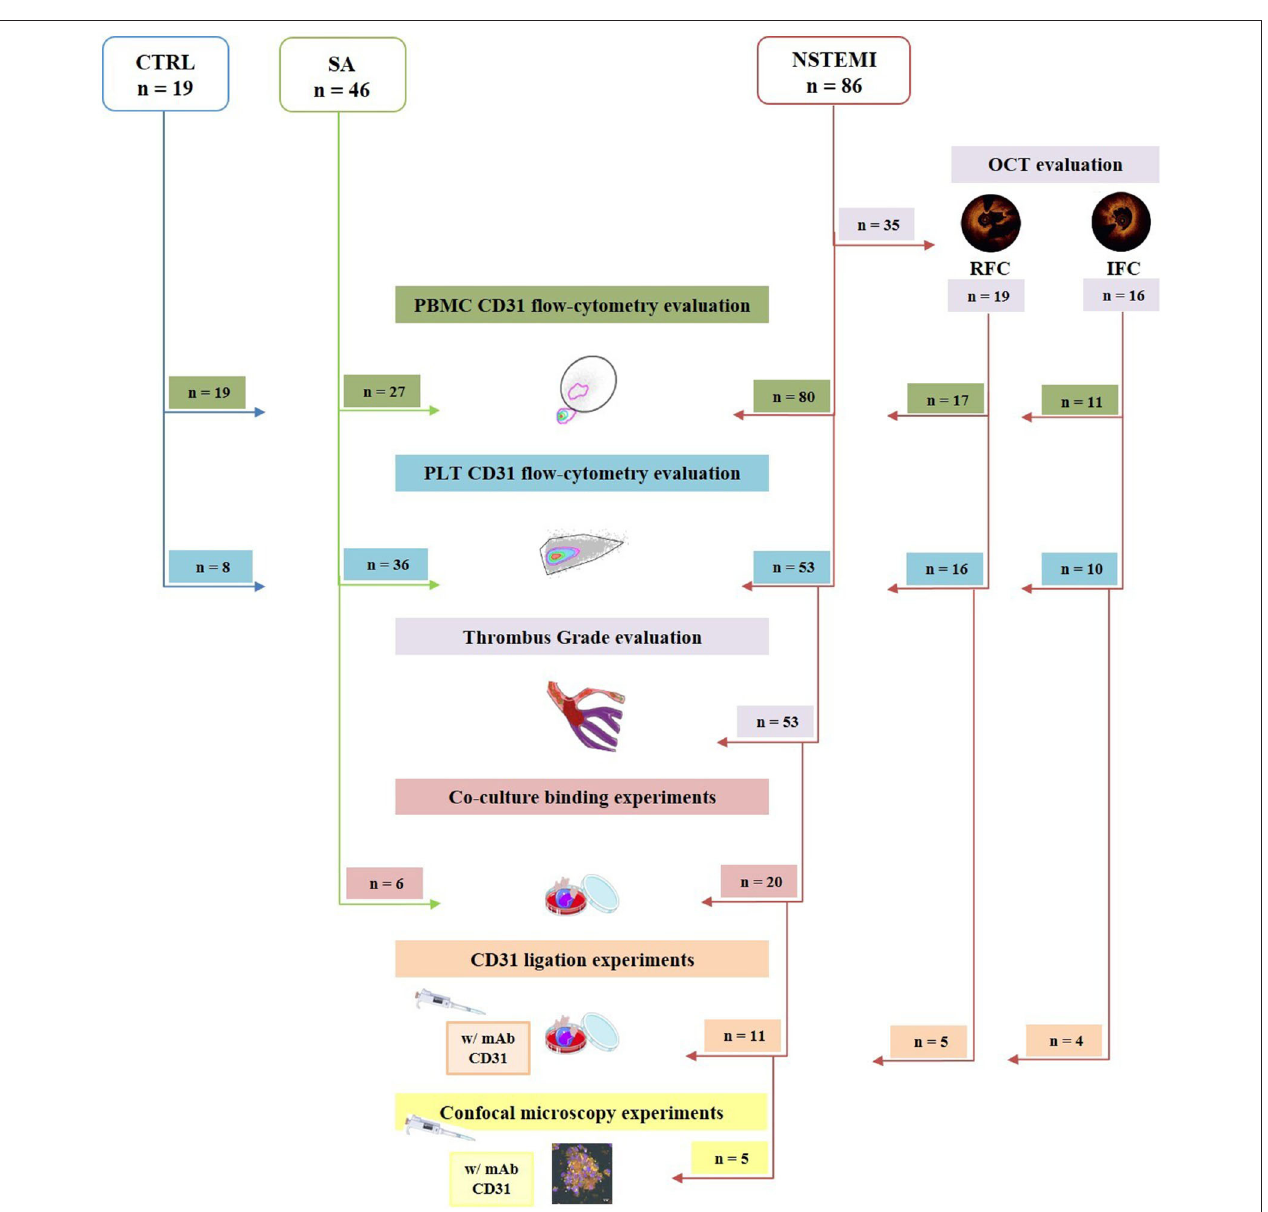
FIGURE 1 | Flow chart showing the enrolled study population and its allocation within the main experimental procedures. Of 86 patients with NSTEMI, 35 underwent OCT investigation, defining n = 16 IFC, and n = 19 RFC. Obtained PBMC from 80 NSTEMI, 27 patients with SA and 19 CTRL subjects enrolled were evaluated for CD31 expression by flow cytometry. Platelet CD31 was assessed by flow-cytometry on 53 NSTEMI, 36 patients with SA, and 8 CTRL subjects. Thrombus grade analysis was performed on the latter 53 patients with NSTEMI. For co-culture binding experiments, 20 NSTEMI and 6 SA were employed. Finally, 11 were engaged for CD31 ligation experiments; of those patients, 5 were investigated through confocal microscopy. CTRL, control subjects; IFC, intact fibrous cap; NSTEMI, non-ST-elevation myocardial infarction; PBMCs, peripheral blood mononuclear cells; PLTs, platelets; RFC, ruptured fibrous cap; and SA, stable angina patients (art images from http://smart.servier.com/